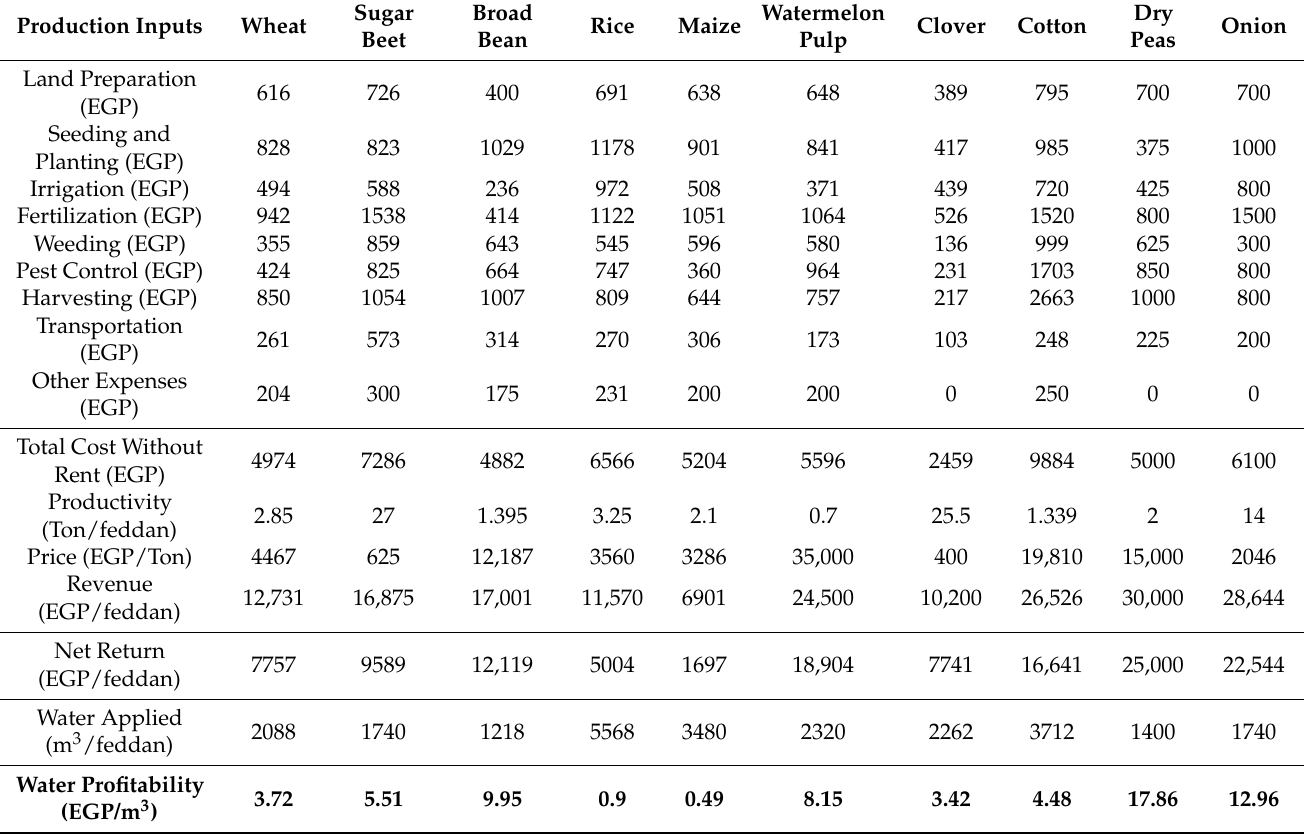
Table 4. Water profitability analysis for Kafr El-Sheikh Governorate in 2020, source: field data collected from farmers and verified by